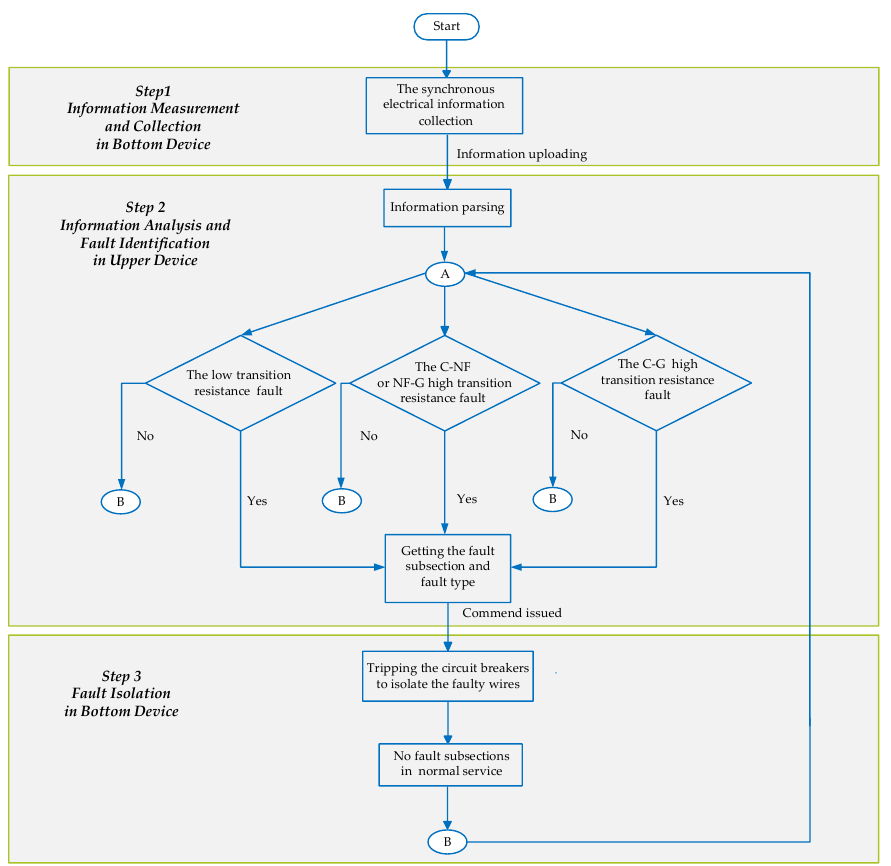
Figure 10. Flowchart of the protection system for the novel segmental all parallel AT TPSS.